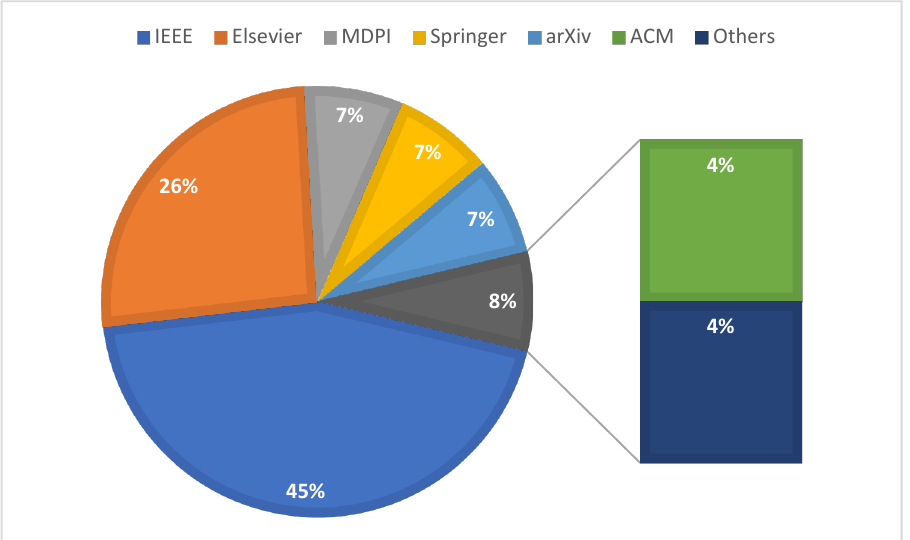
Figure 8. Distribution of the selected papers by publisher.